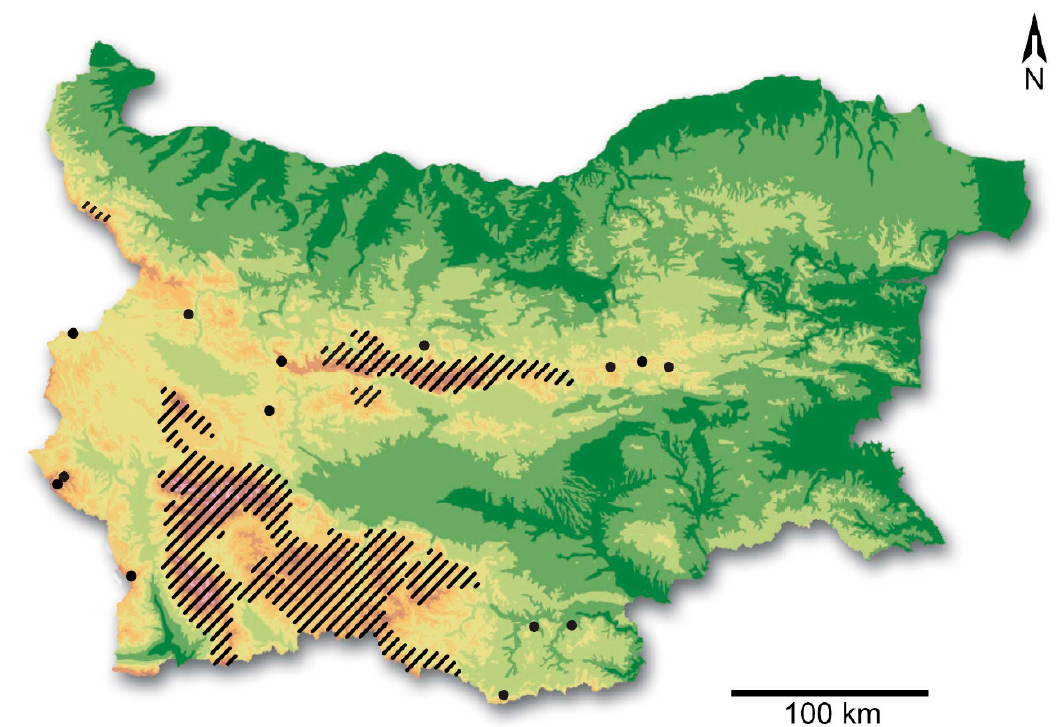
Figure 1. Recent distribution of the brown bear in Bulgaria (from sources: [2,6,7], with additions). Hachured areas: presence of local subpopulations, dots: single specimens/wandering individuals/temporary (periodic) appearances/seasonal sporadic appearance. The northern hatchured area represents the distribution of the bear in the Balkan mountain range, and the southern in the Rila-Rhodopean mountain massif. The brown colors correspond to the mountainous regions.